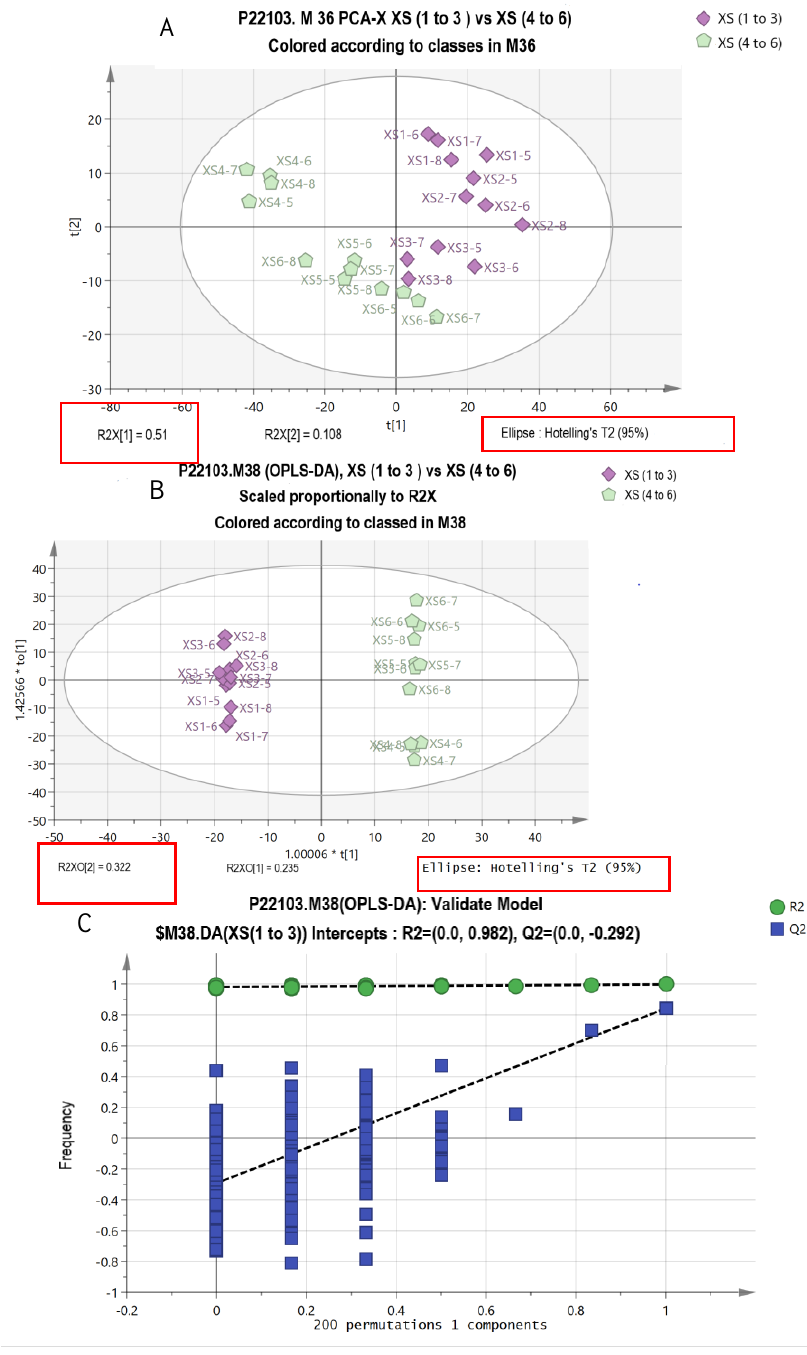
Figure 1. ( A ). Principal components analysis (PCA) of plasma metabolites from yak ( n = 8) fed with a low- (1 to 3) and high-protein (4 to 6) diet. ( B ). Orthogonal correction partial least squares discriminant analysis (OPLS-DA) of the plasma metabolites from yak ( n = 8) fed with a low- (1 to 3) and high-protein (4 to 6) diet. ( C ). OPLS-DA model permutation test chart. Table 8. Different metabolites content in the plasma of yaks fed low- and high-protein diets. Compounds